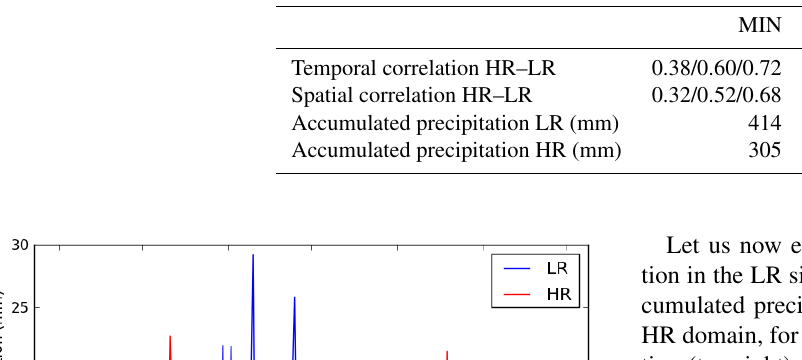
Table 1. Comparison of precipitation statistics between LR and HR simulations. Space-averaged temporal correlation for the hourly, daily, and weekly precipitation amounts, respectively (first row); same for the time-averaged spatial correlation (second row); accumulated precip- itation (mm) averaged over the HR domain from the whole LR and HR simulation time series (third and fourth rows).